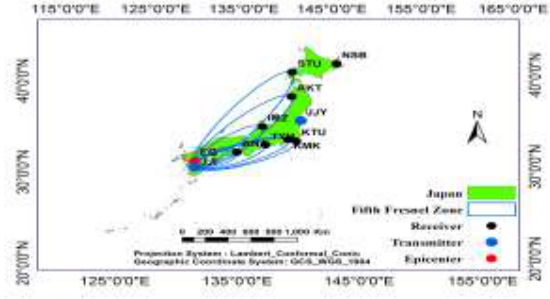
Figure 2 Fifth Fresnel zone of the receiver-transmitter